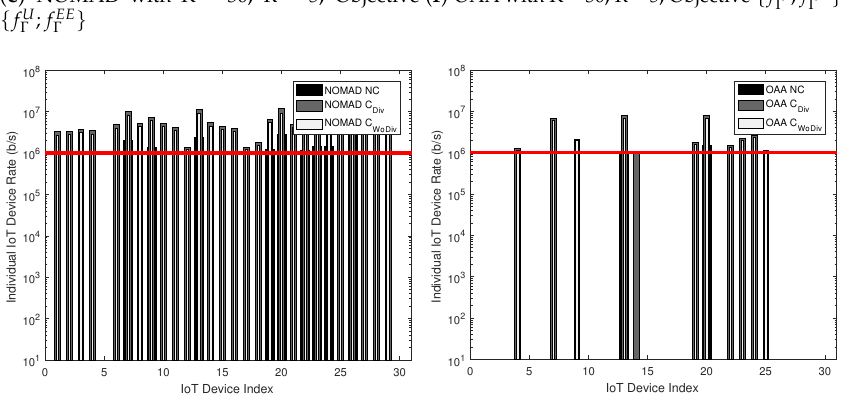
Figure 5. Rate of each IoT Device/Mobile Users for various parameters. Required rate 1 Mbps, P max = 20